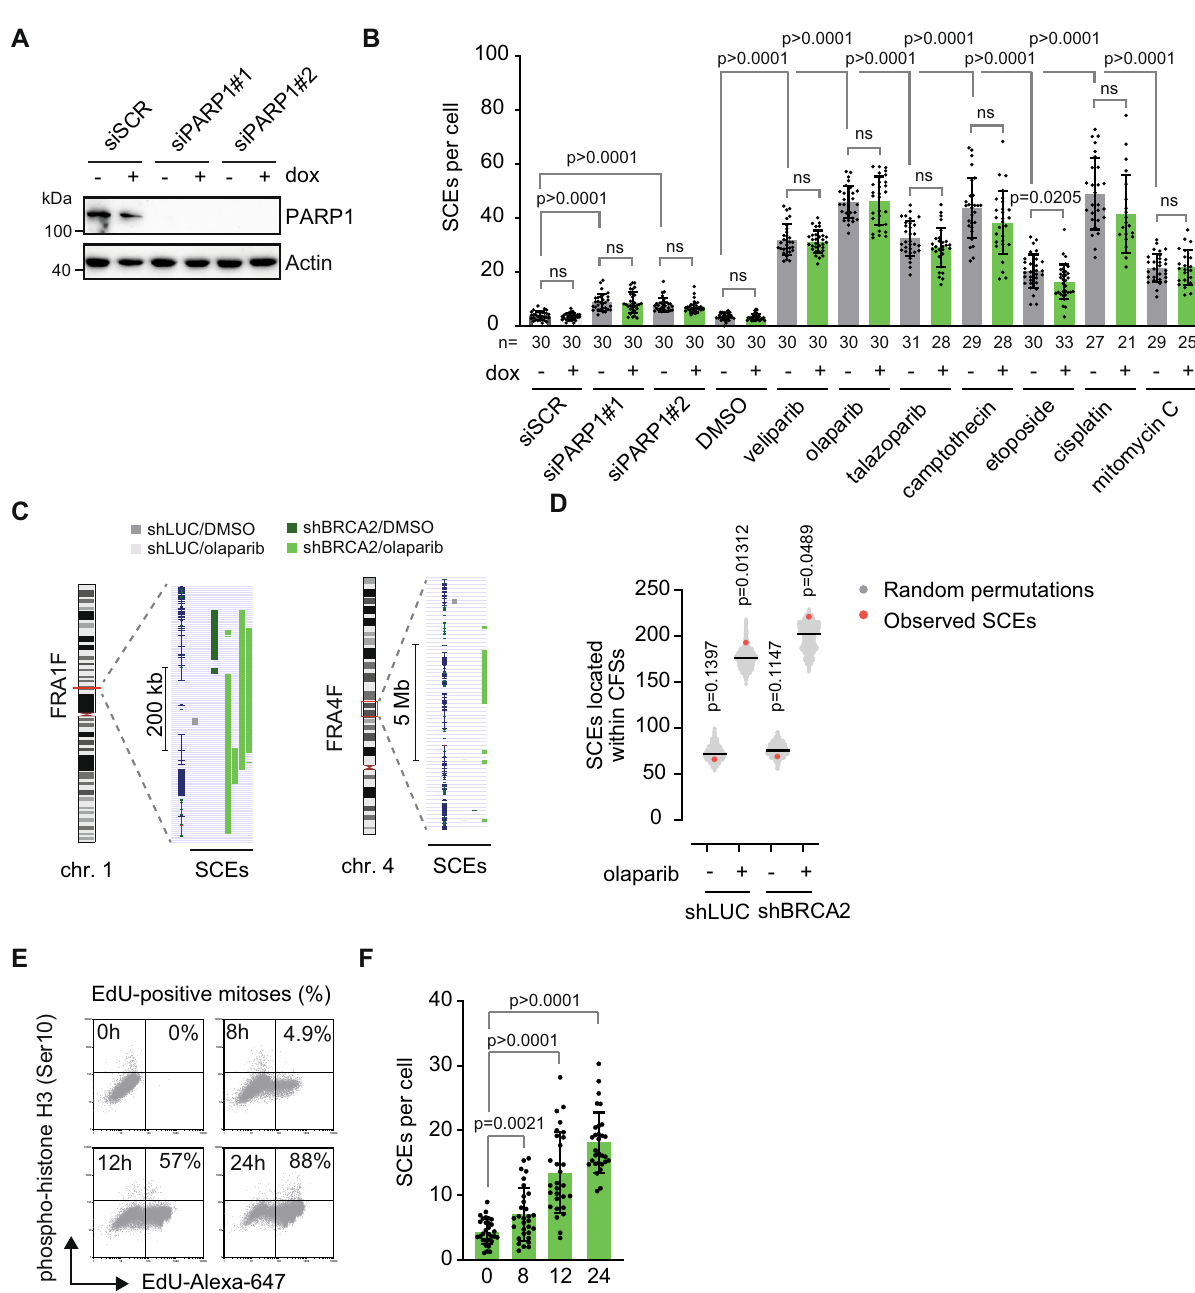
performed using one-sided permutation with 10,000 iterations ( D ). P values indi- cate deviation of the observed number of SCEs compared to the mean of all per- mutations. SCE mapping to the common fragile sites FRA1F and FRA4F are presented as illustrative examples ( C ). E , F Doxycycline pre-treated RPE-1 TP53 -/- shBRCA2cells weretreated withethynyldeoxyuridine(EdU)fortheindicated time periods,andsubsequentlyanalyzedformitoticcellsby fl owcytometryofphospho- histone H3 (Ser10). Percentages of mitotic cells that were EdU-positive are indi- cated ( E ). Doxycycline pre-treated RPE-1 TP53 -/- shBRCA2 cells were treated with olaparib for the indicated time points, and SCEs were quanti fi ed by microscopy analysis of 30/31/29/30 metaphase spreads per condition from one biologically independent experiment ( F ). Means and standarddeviations are plotted. Statistics in panels B and F were performed using unpaired two-tailed t -tests (ns: non-sig- ni fi cant), and gray bars indicate HR-pro fi cient conditions, green bars indicate HR- defective conditions. Source data are provided with this